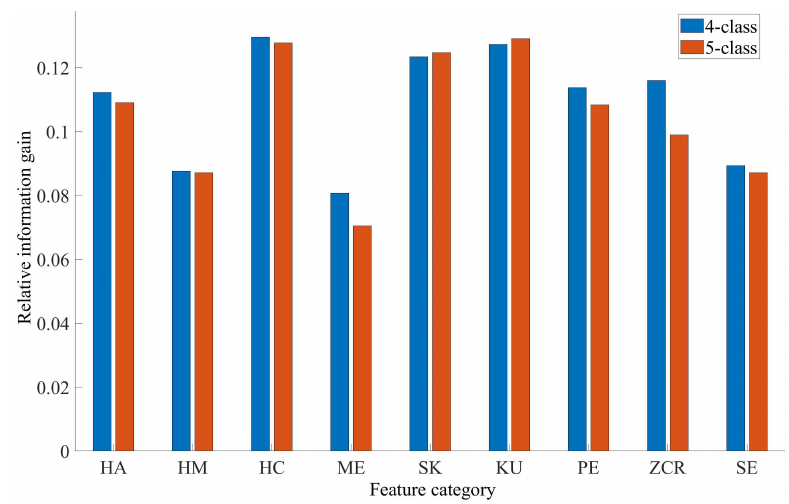
Figure 8. Relative information gain of SHHS database features in the XGBOOST